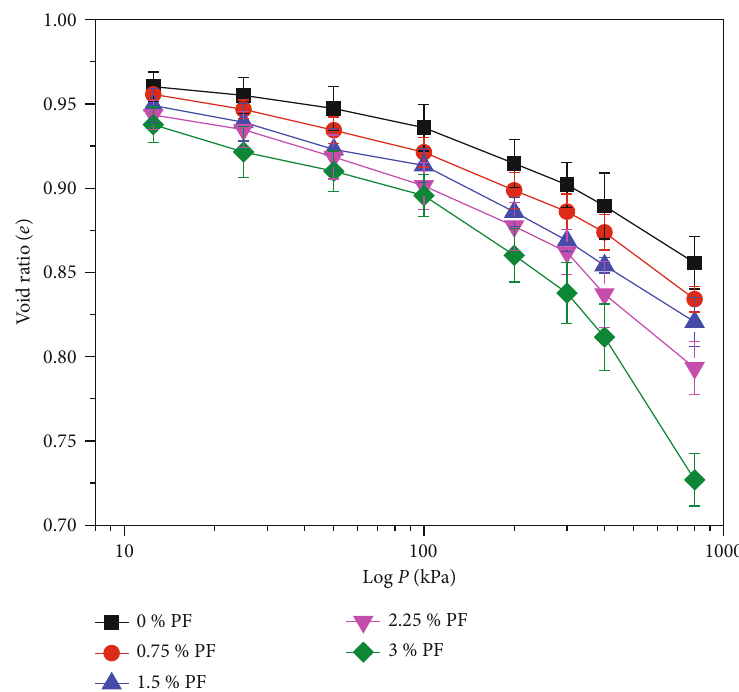
Figure 7: Void ratio ( e ) and log P values for unstabilised and PF-stabilised soils.